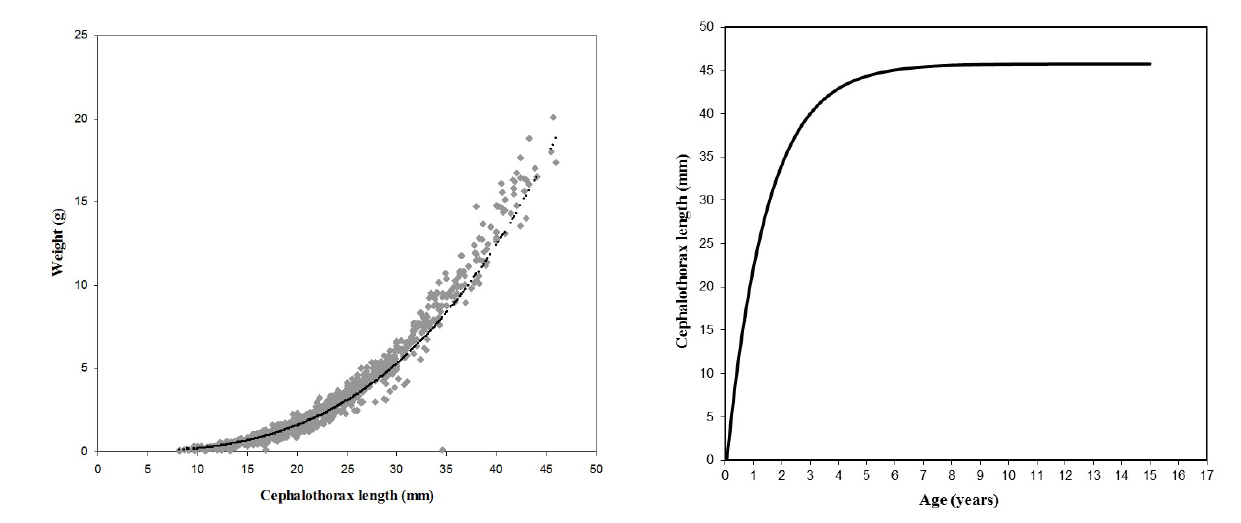
Figure 2. Length growth curve of the burrowing crayfish Parastacus nicoleti adjusted to the von Bertalanffy (1938) model.